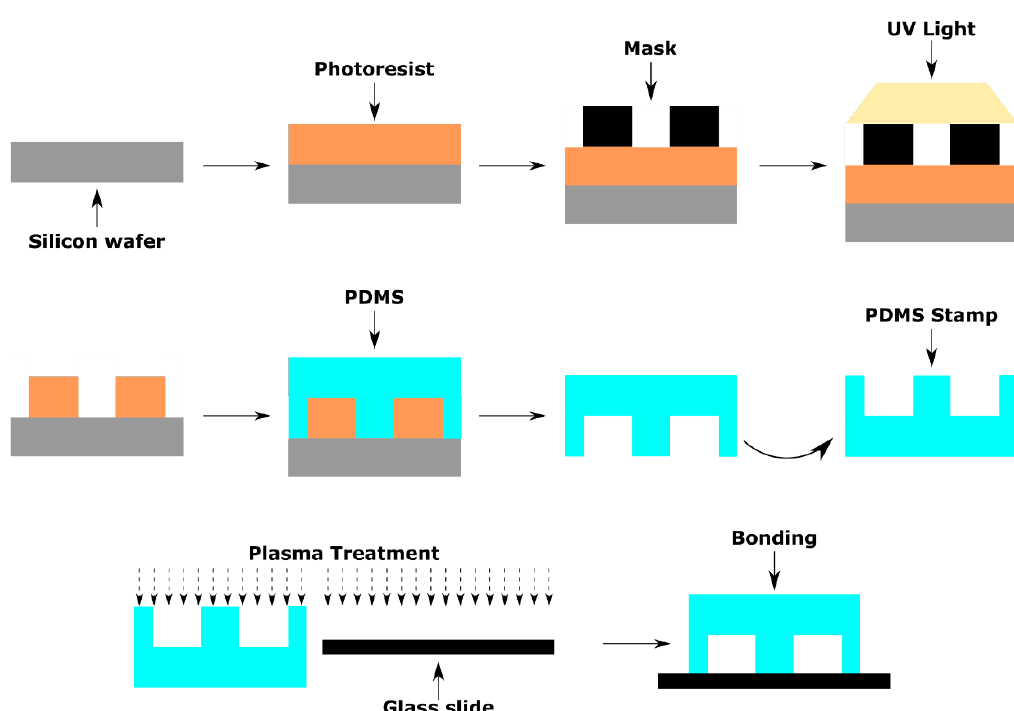
Figure 2. An example of replica molding using poly(dimethylsiloxane) (PDMS). The typical photolithography steps are taken utilizing photoresist, a mask, and UV exposure to create the master. The master mold is filled with PDMS and cured. Once cured, the PDMS is removed from the master and bonded to a glass slide for plasma oxidation.